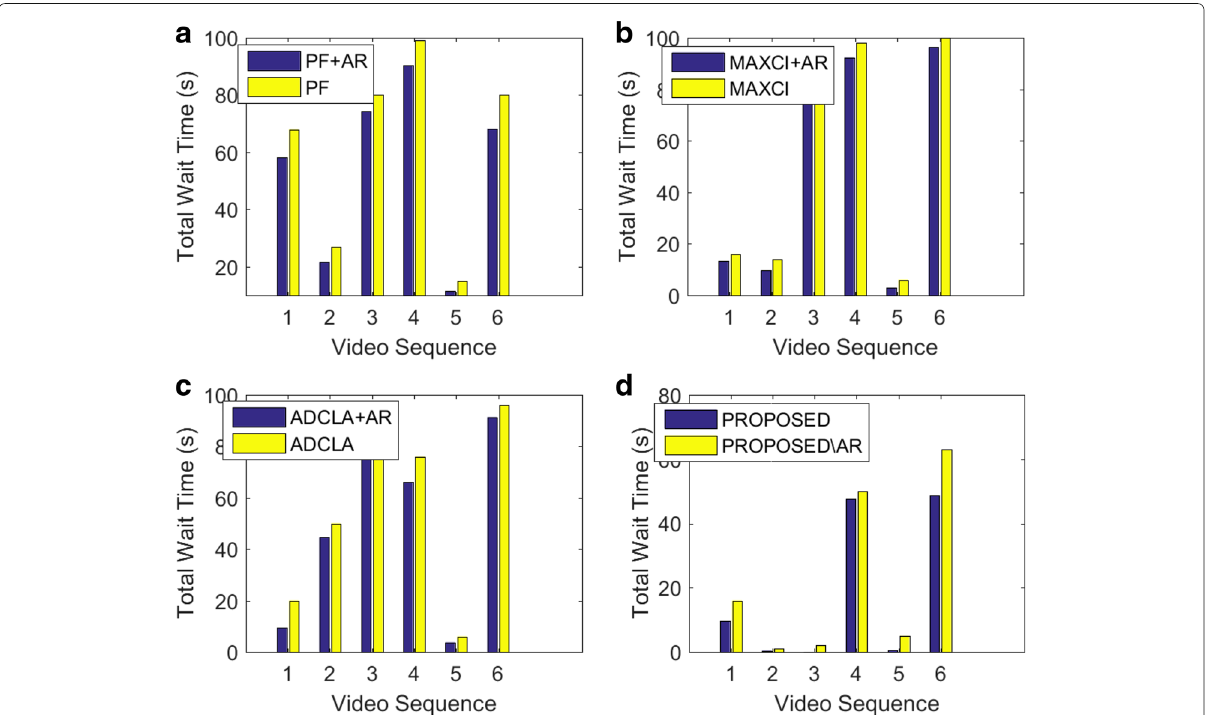
Fig. 9 The comparison of interruption time experienced by each client for different packet scheduling and resource management algorithms by employing our proposed segment request scheme AR or not. a Interruption time experienced by each client for PROPOSED vs. PROPOSED-AR. b Interruption time experienced by each client for ADCLA+AR vs. ADCLA. c Interruption time experienced by each client for MAXCI+AR vs. MAXCI. d Interruption time experienced by each client for PF+AR vs.